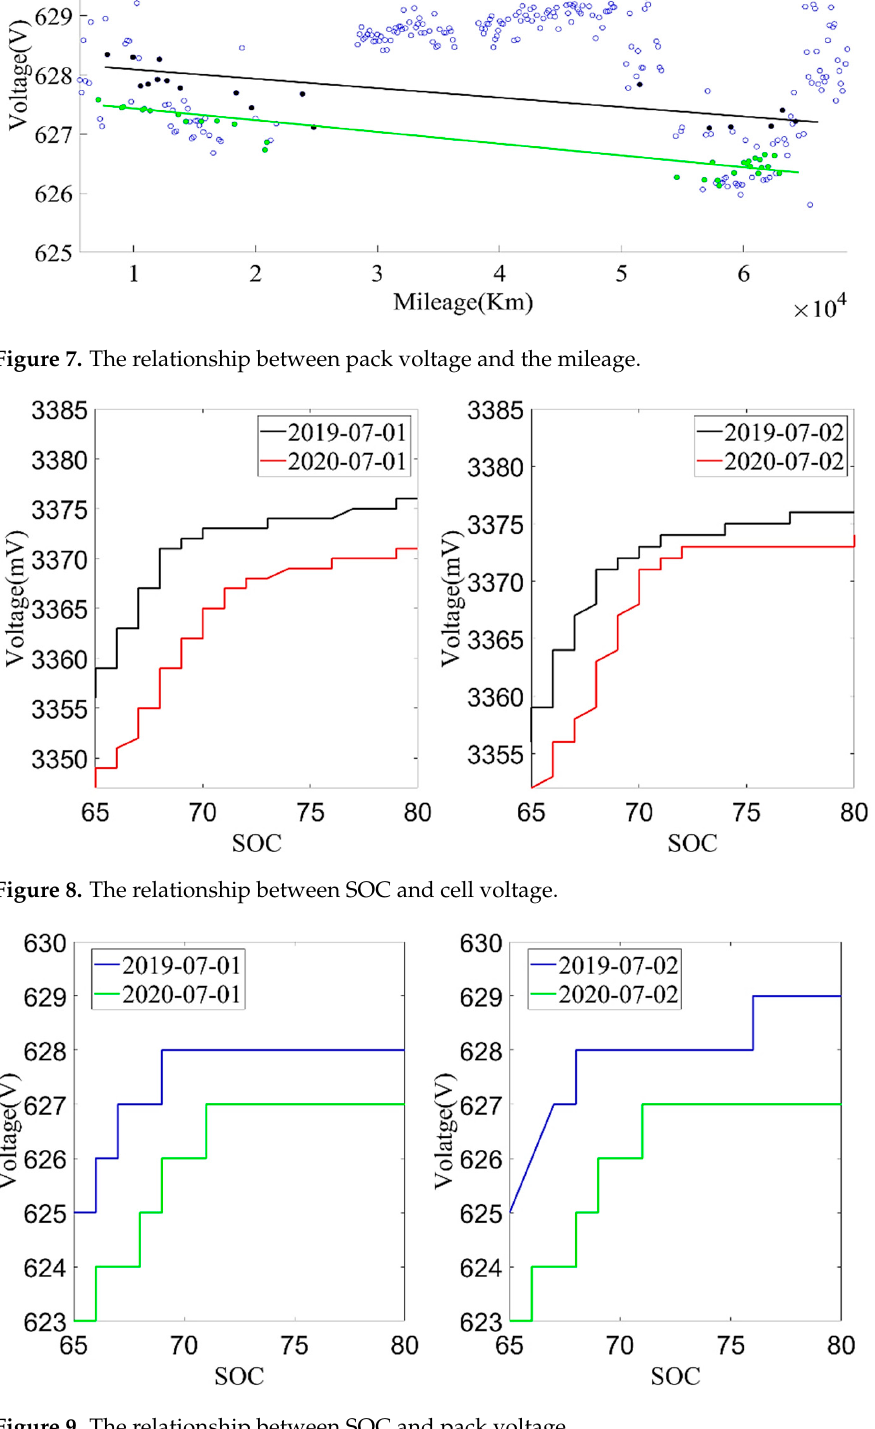
Figure 7. The relationship between pack voltage and the mileage.